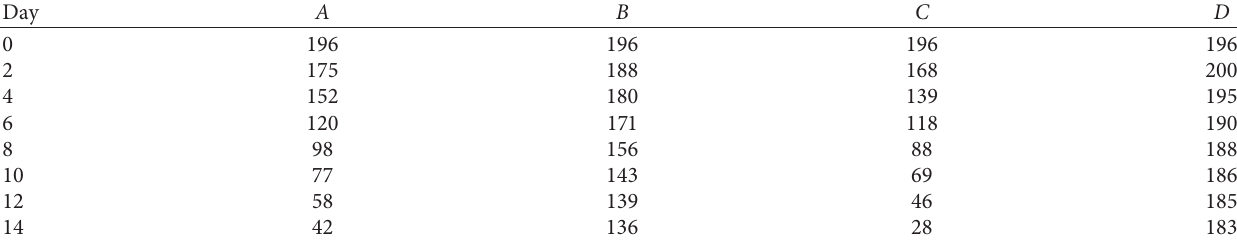
Table 7: The COD value change data table of the combined treatment of microorganisms and plants. Day